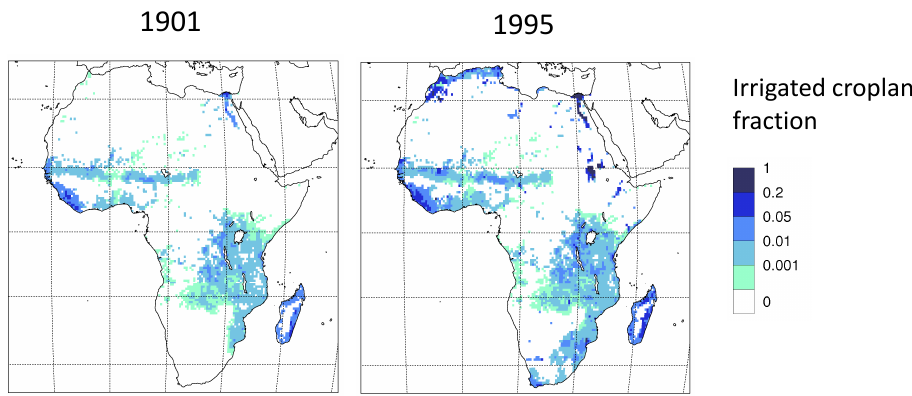
Fig. A5. Irrigated cropland fractions for the years 1901 (representing a state when only rice was assumed to be irrigated) and 1995 (from Döll and Siebert, 1999).